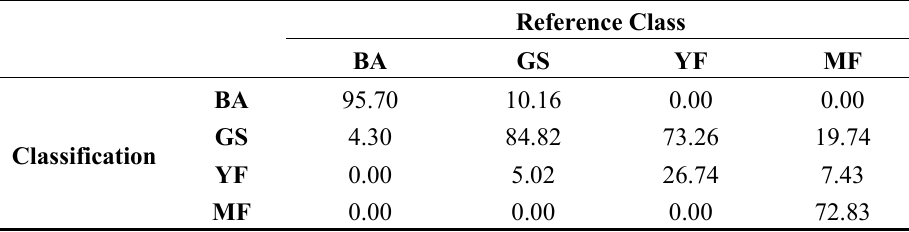
Table 2. Accuracy assessment of Classification 1 (per cent): image segmentation and classification using ALOS AVNIR and topographic data (overall accuracy: 0.666, Kappa: 0.56).